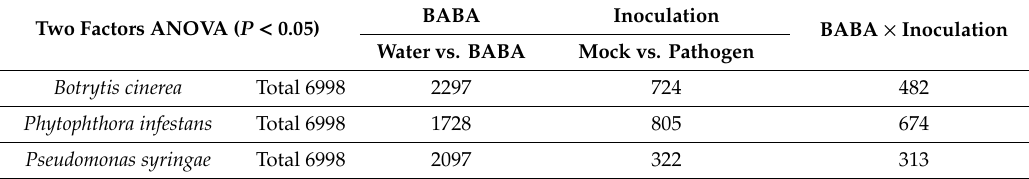
Table 2. Univariate statistical analysis for each